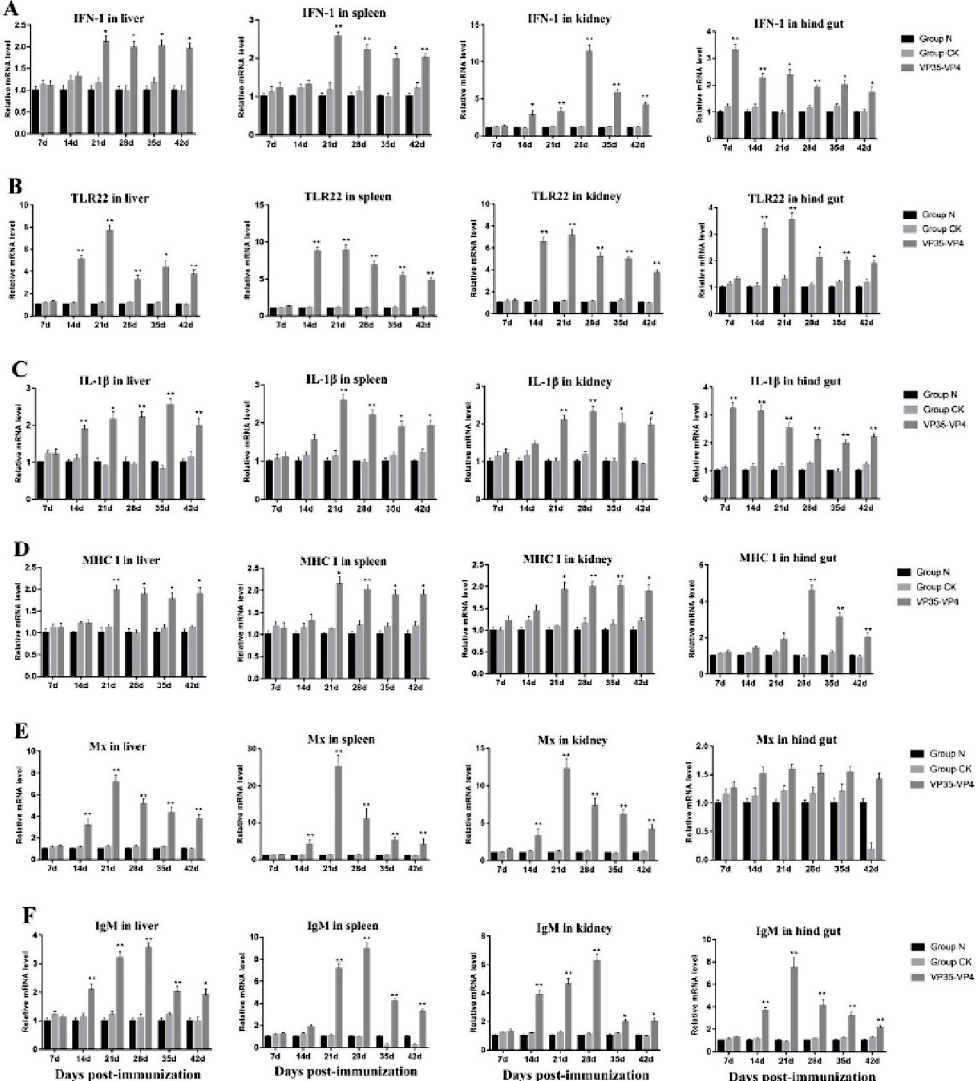
Figure 7. qRT-PCR analysis of the expression of immune-related genes in different tissues of the grass carp on Days 7, 14, 21, 28 and 42 after immunization with oral vaccine: ( A ) IFN-1; ( B ) TLR22; ( C ) IL-1 β ; ( D ) MHC I ( E ) Mx; and ( F ) IgM. The mRNA level of each gene was normalized on the basis of β -actin gene expression. * p < 0.05; ** p < 0.01. The significant difference is compared against the group CK group. The relative mRNA expression levels of the immune-related genes were calculated using the 2 − ∆∆ Ct